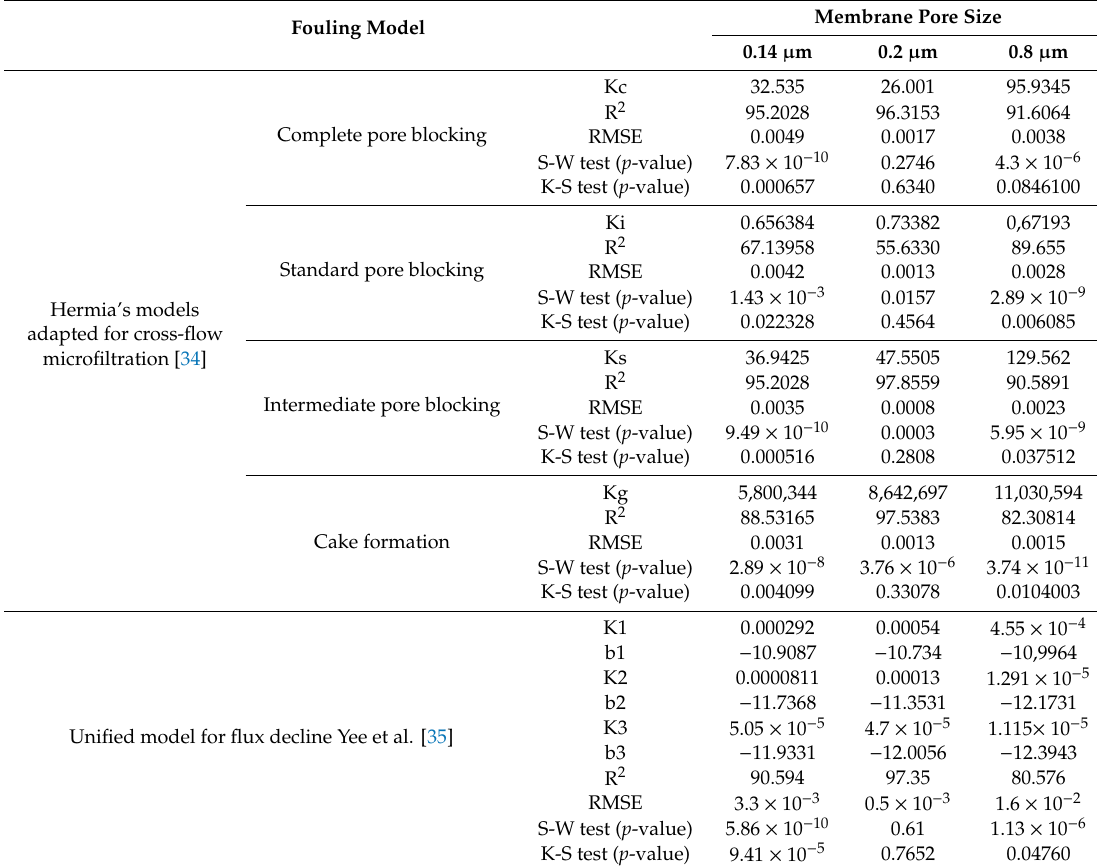
Table 3. Fitted parameters for fouling models according to the modified Hermia’s models for cross-flow filtration, unified model of flux decline, and statistical model analysis for the studied membranes. S-W: Shapiro–Wilks test; K-S: Kolmogorov–Smirnov test; RMSE: root mean square